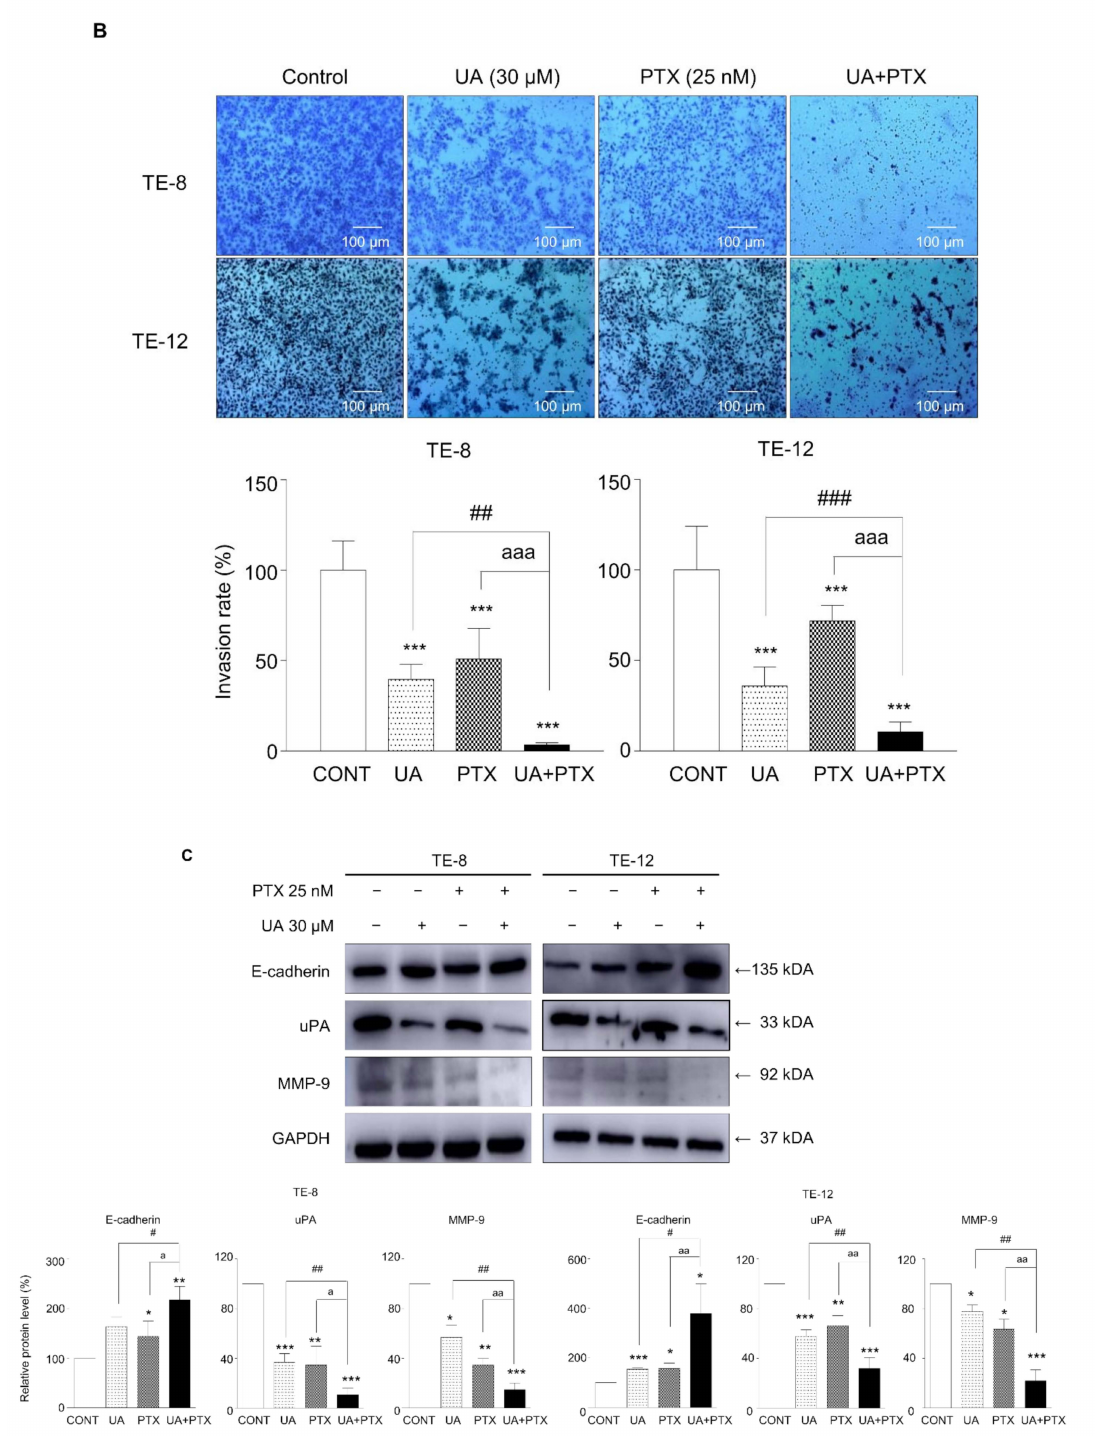
Figure 4. UA and PTX inhibited cell invasion and metastasis in ESCC cells. ( A ) Wound healing assay was designed to assess cell migration. Images were taken at 12 h and 24 h. ( B ) Matrigel-migration assay was performed to detect the invasion rate. The combination treatment inhibited the invasion rates significantly better than the single agents. ( C ). Effects of UA and PTX on migration-related proteins. Expression of E-cadherin, uPA and MMP-9 was examined by western blotting. GAPDH is the internal control. Quantification of bands was calculated using ImageJ. *, compared with the control group; # , UA compared with the UA plus PTX combination group; a , PTX group compared with the UA plus PTX combination group. # , a , * p < 0.05; ## , aa , ** p < 0.01 and ### , aaa , *** p < 0.001. Scale bar: 100 µ m. CONT, control; UA, ursolic acid 30 µ M; PTX, paclitaxel 25 nM; UA+PTX, combination treatment of ursolic acid 30 µ M and paclitaxel 25